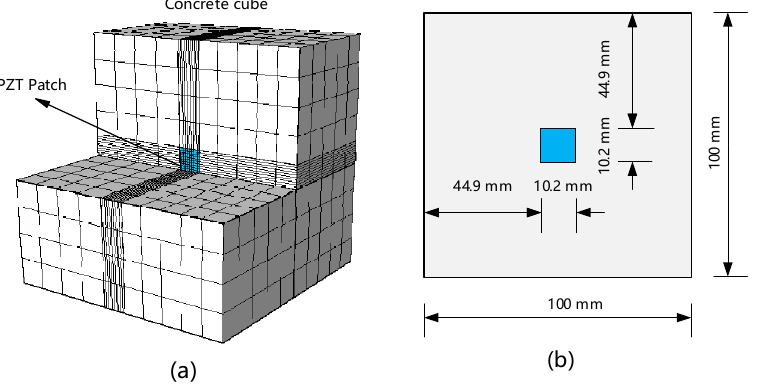
Figure 3. ( a ) The typical FE model for concrete specimens and ( b ) the detailed dimensions of the embedded PZT sensor.